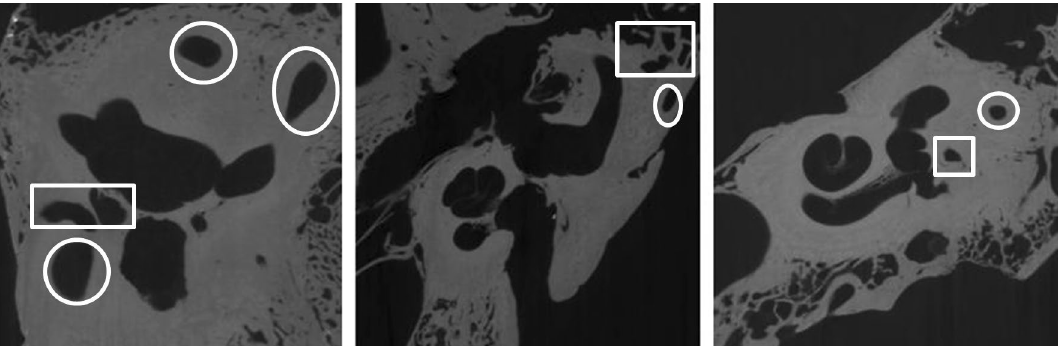
Figure 1. Difficulties in segmenting similarly looking structures in inner ear CTs (using independent image slices). Structures that are part of the inner ear are highlighted with a circle whereas the structures not part of the inner ear are highlighted with a